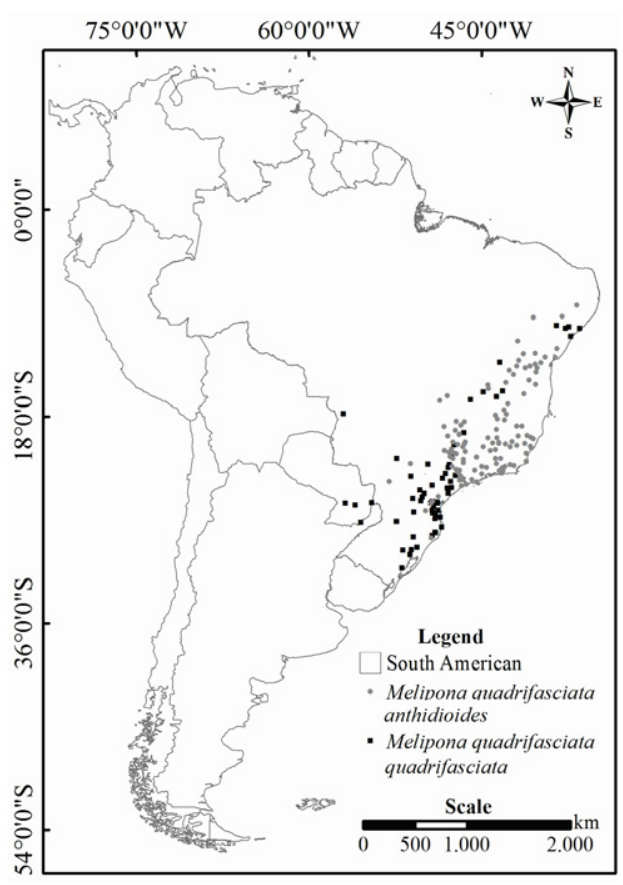
Fig 1 . Spatial distribution of records of the two Melipona quadrifasciata subspecies in Brazil. Grey circles represent the records of M. q. anthidioides , and black squares the M. q. quadrifasciata